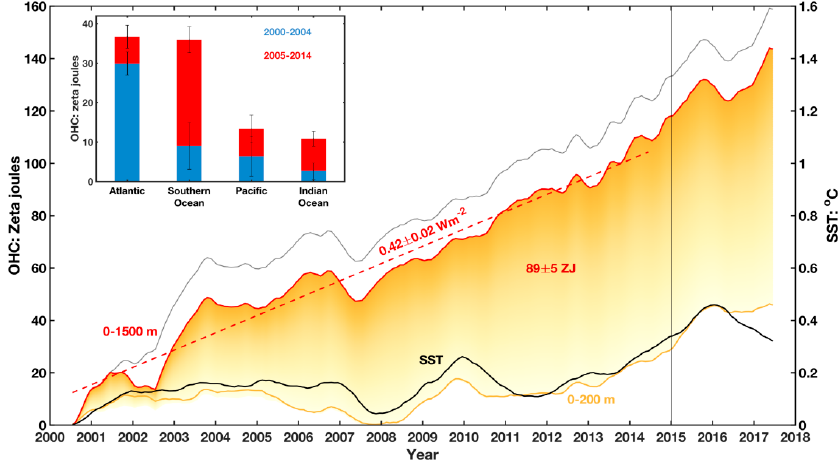
Figure 5. Global mean SST and OHC relative to 1998: SST from ERSST.v4 is in black and 0–200 m OHC in light orange curve, showing that they co-vary and both are in a warming slowdown, while the “total” OHC, as approximated by the 0–1500 m OHC in red curve, is increasing at the regressed linear rate of 0.42 W·m − 2 (red dashed straight line). The orange shaded region is the amount of heat stored in the 200–1500 m layer, and it is about 89 zetajoules for the period 2000–2014. The data were adjusted by us for the Southern Ocean to remove a possible artifact due to the rapid transition from no-Argo to Argo observing platform around 2002–2003, as pointed out by Cheng and Zhu [65]. The original data [66] for the unadjusted 0–1500 m OHC are shown in grey. The inset shows the division of the 89 zetajoules of the global ocean increase in heat storage in 200–1500 m (linear trend multiplied by the number of years) into the four ocean basins. Note that the definition of the Southern Ocean in oceanography and here is south of 35S. The tip of the Drake Passage is at 38S. The error bars are from the linear trend regression. For the subsurface ocean heat content we use Ishii data [66], which is available up to 2012. Most of the recent measurements are from the Argo floats